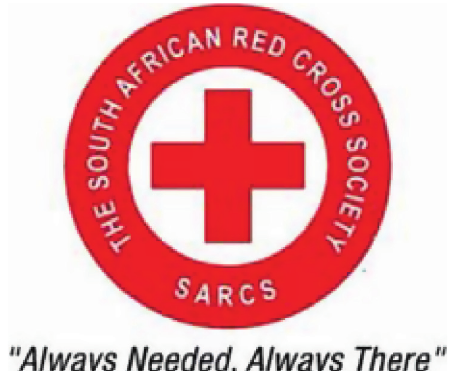
Figure 11: The South African red cross society: site